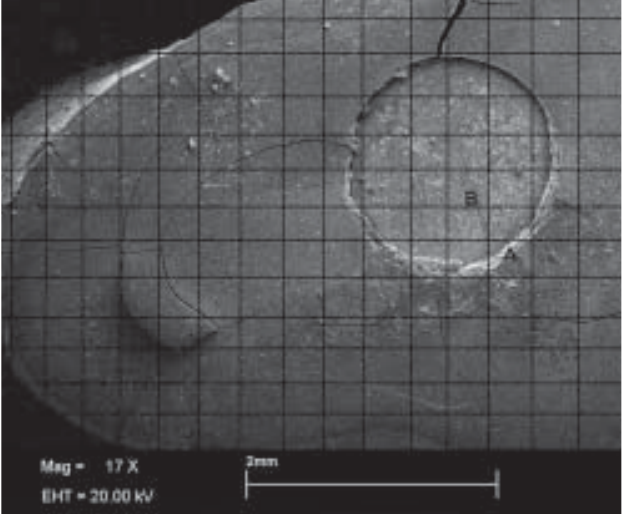
Figure 2. Specimen of Group I. Area occupied by root canal sealer (A), Resilon (B), and occasional empty space (C), with integration grid inserted (×20 magnification).